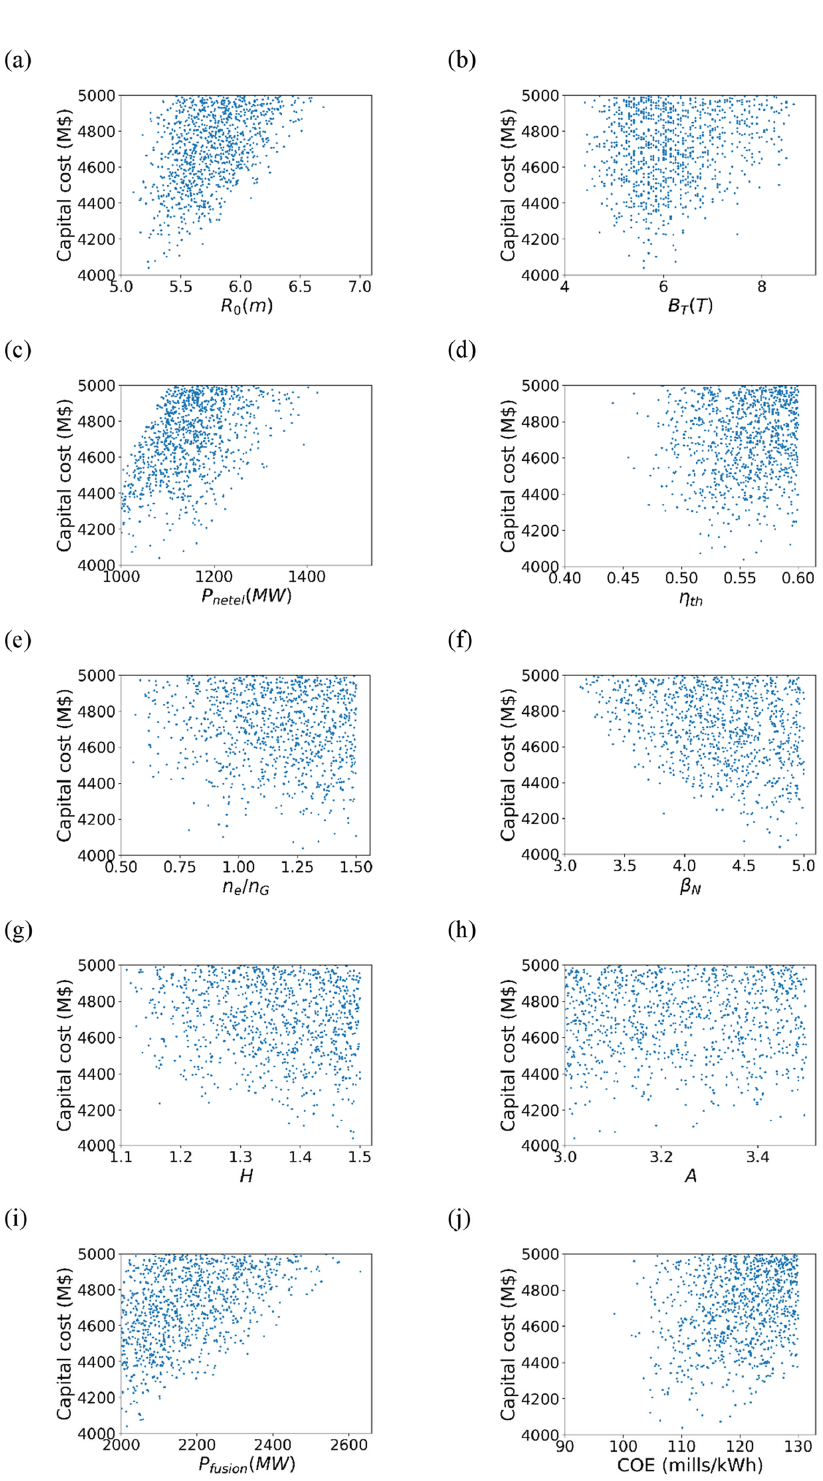
Figure 6. Variation of capital cost on ( a ) R 0 ; ( b ) B T ; ( c ) P e ; ( d ) η th ; ( e ) n e /n G ; ( f ) β N ; ( g ) H ; ( h ) A ; ( i ) P fusion , and ( j ) COE for the case without the CS. Similar trends appear with wider windows for the cost reductions. R 0 was between 5.1 and 6.7 m; for a lower COE, the range narrowed, with the mean value fixed; for a lower capital cost, the range narrowed, with the mean value shifted to a smaller R 0 . The B T value was between 4.4 and 8.7 T, with B max < 16 T, and the range narrowed with a smaller B max for a lower COE and capital cost. P e was between 1000 and 1420 MW; for a lower COE,